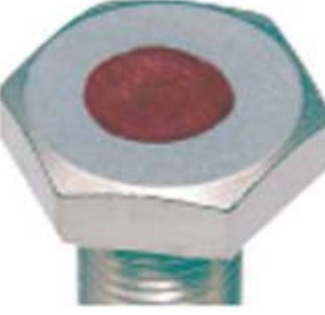
Figure 6. Marked bolt (red ϕ 9).